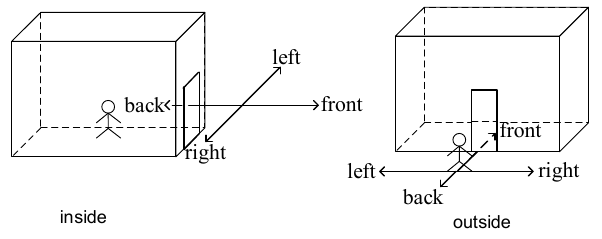
Figure 4. Definition of semantic direction